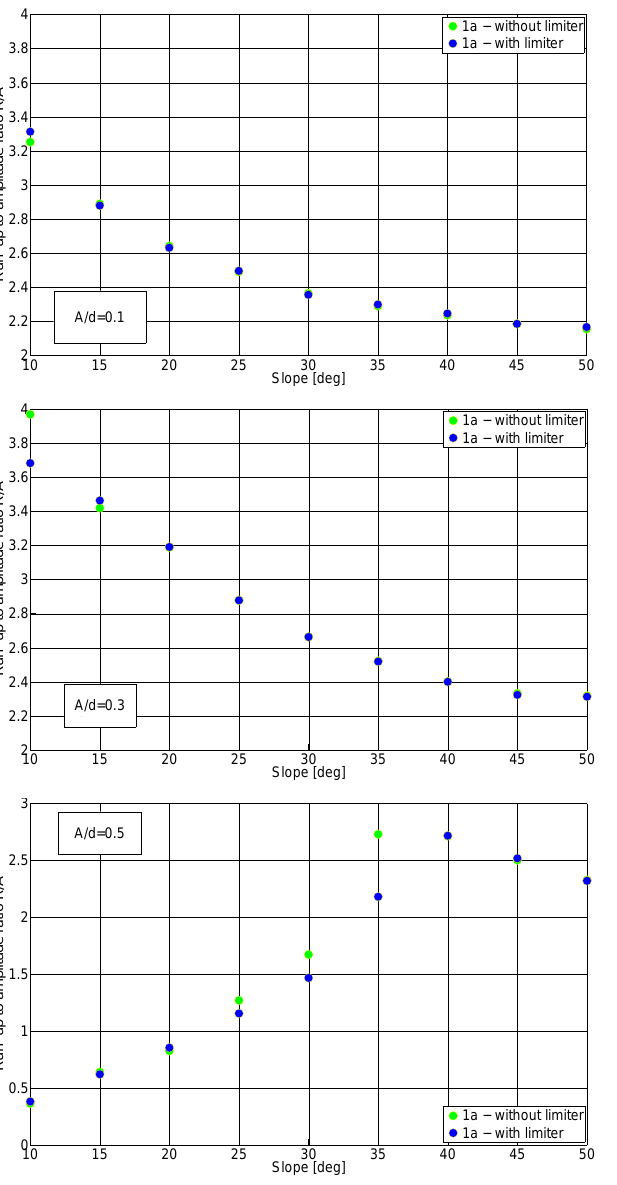
Fig. 7. Run-up ratio for solitary wave run-up in COULWAVE for different slopes and initial amplitudes. Upper panel, A/d = 0 . 1, mid panel A/d = 0 . 3, lower panel A/d = 0 . 5. Three different run-up methods are employed. Here, a Courant number of Cr = 0 . 1 is em- ployed. Dropout or underprediction of the R/A values for the gen- tlest slopes indicate instability. Results with Lagrangian models are included for